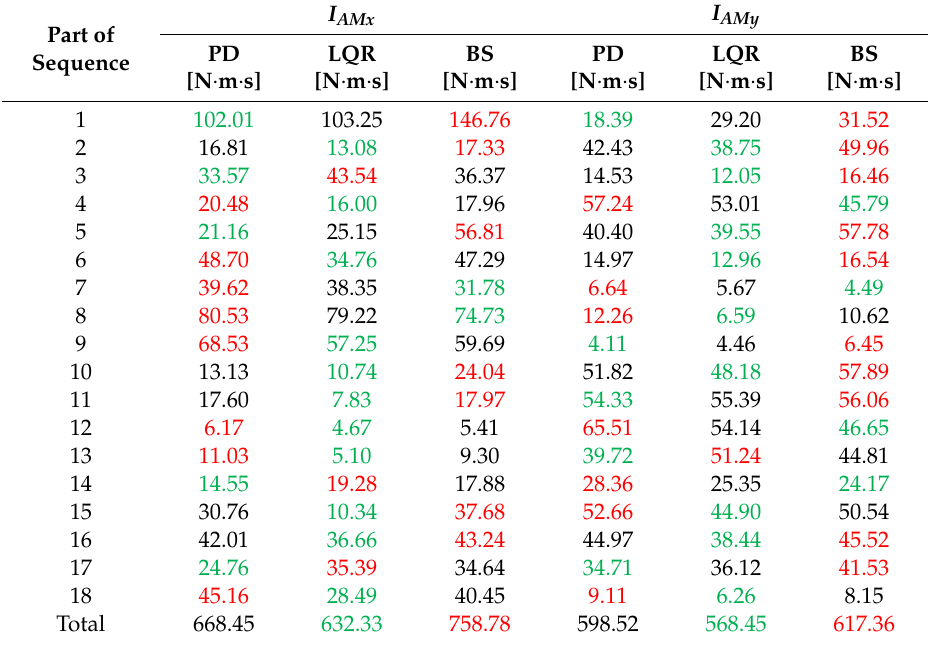
Table A4. Quality indicators of controllers’ performance: Integral of absolute desired torque around